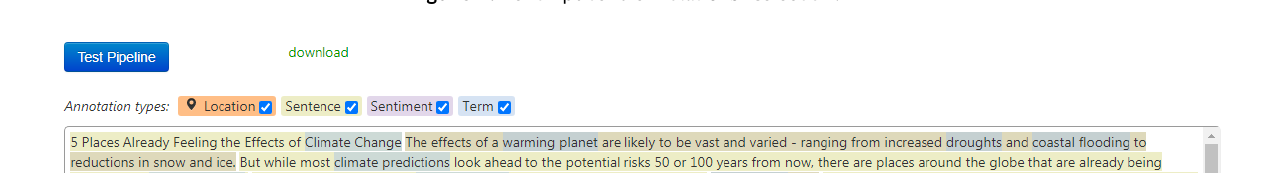
Figure 2. Text input and annotations’ selection.